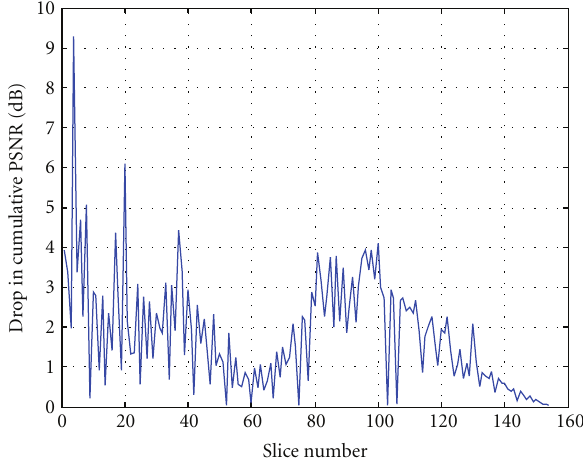
Figure 3: Drop in PSNR for non-IDR slices-Paris sequence